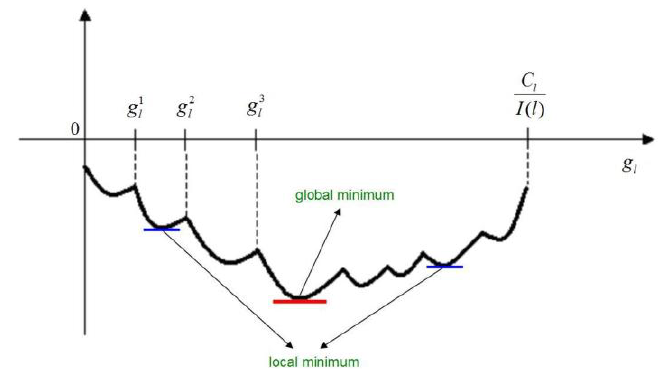
Figure A1. Typical graph of problem (SP